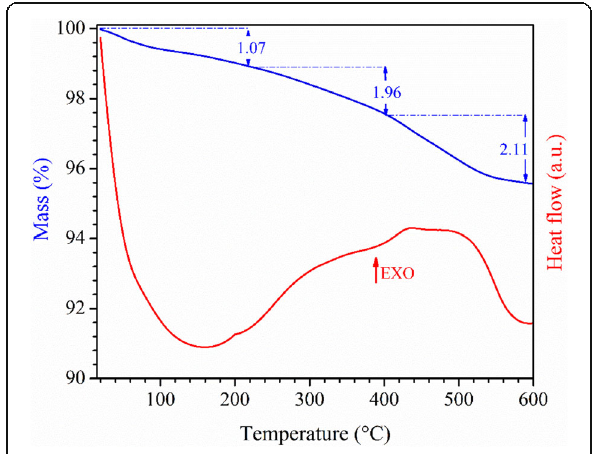
Fig. 7 TG-DTA curves of the sample 2TiMA-ET from 25 to 600 °C